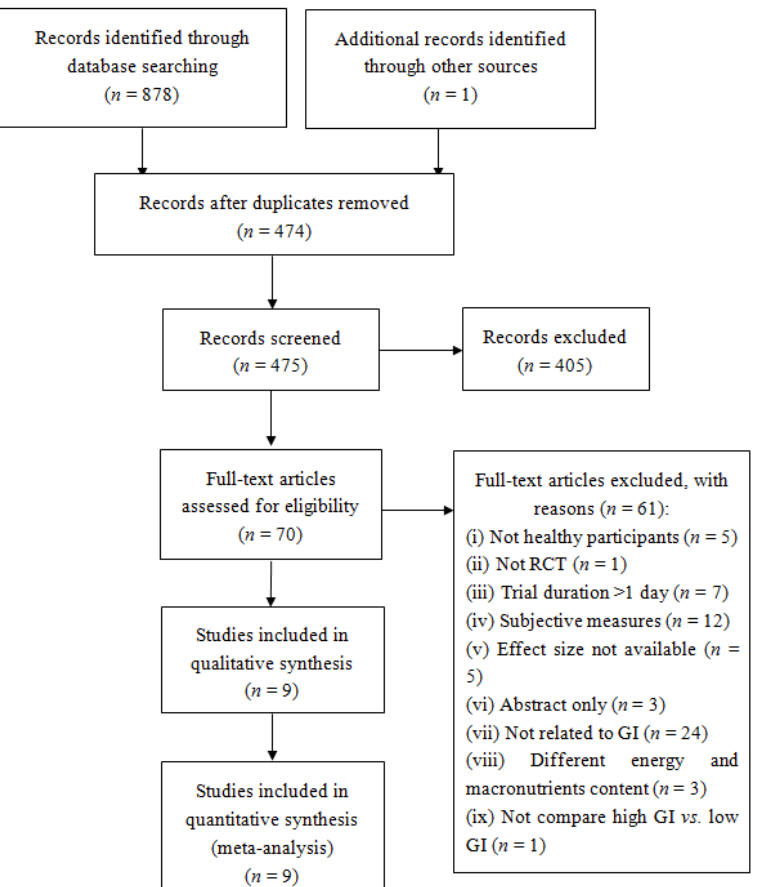
Figure 1. Flow diagram of study selection process.